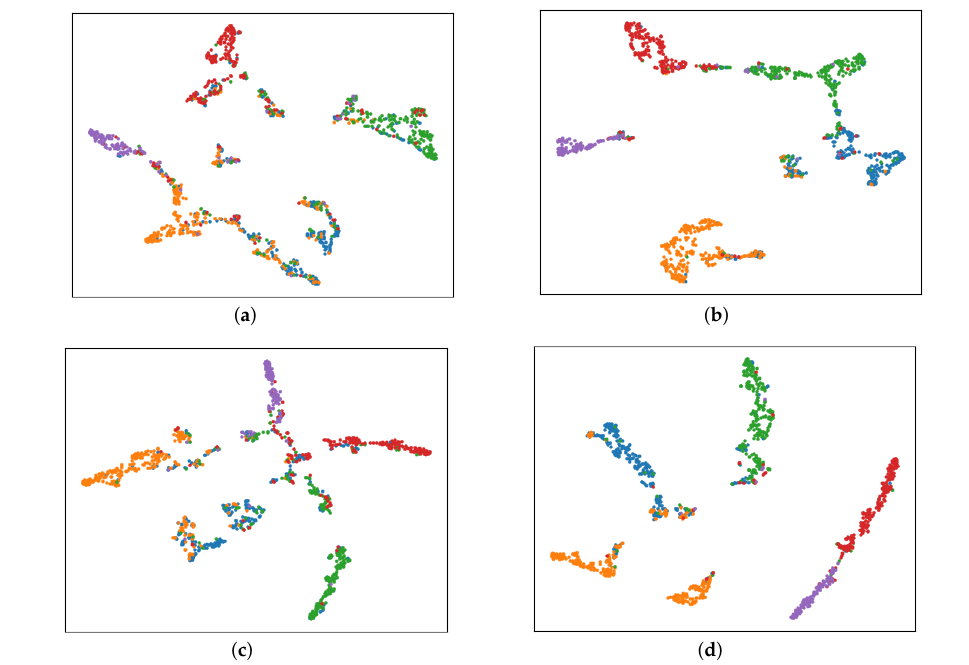
Figure 1. The testing node embeddings learned by GCN and GCNII on acmv9 when trained with 20 nodes per class and 40% nodes per class, visualized by t-SNE. ( a ) GCN: 20 nodes per class; ( b ) GCN: 40% nodes; ( c ) GCNII: 20 nodes per class; ( d ) GCNII: 40%